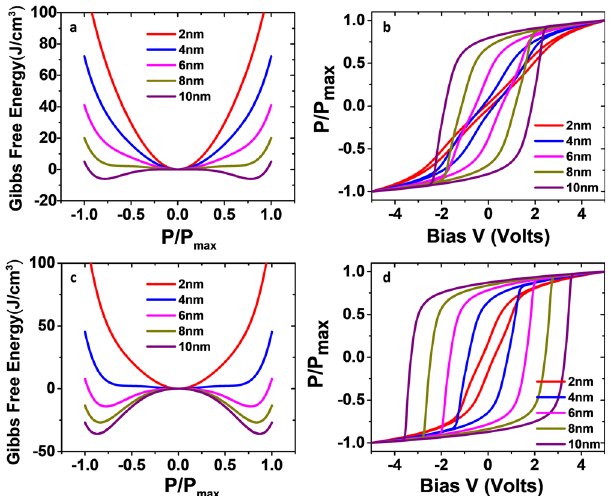
Fig. 5 Interfacial capacitance ( C int ) effect on Gibbs free energy landscape and P – V hysteresis curves. Gibbs free energy landscapes and calculated polarization P - voltage V hysteresis for different ferroelectric thickness t F